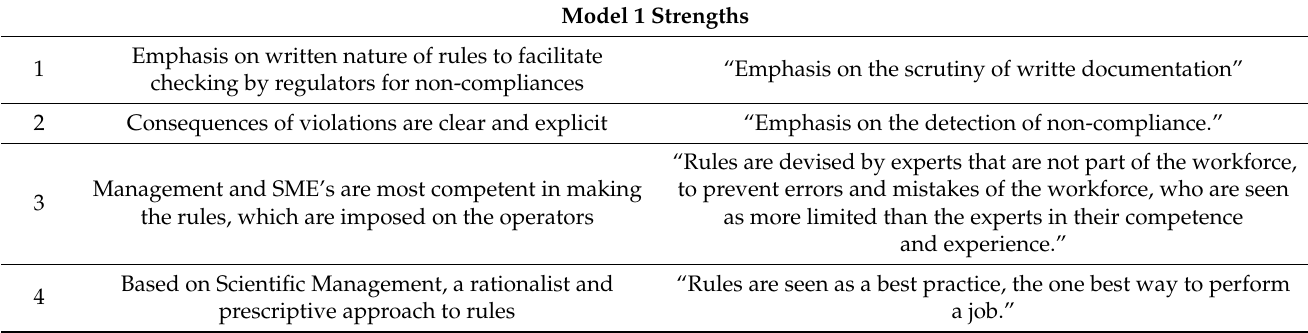
Table A1. The strengths and weaknesses of model 1 and 2 [1] and used